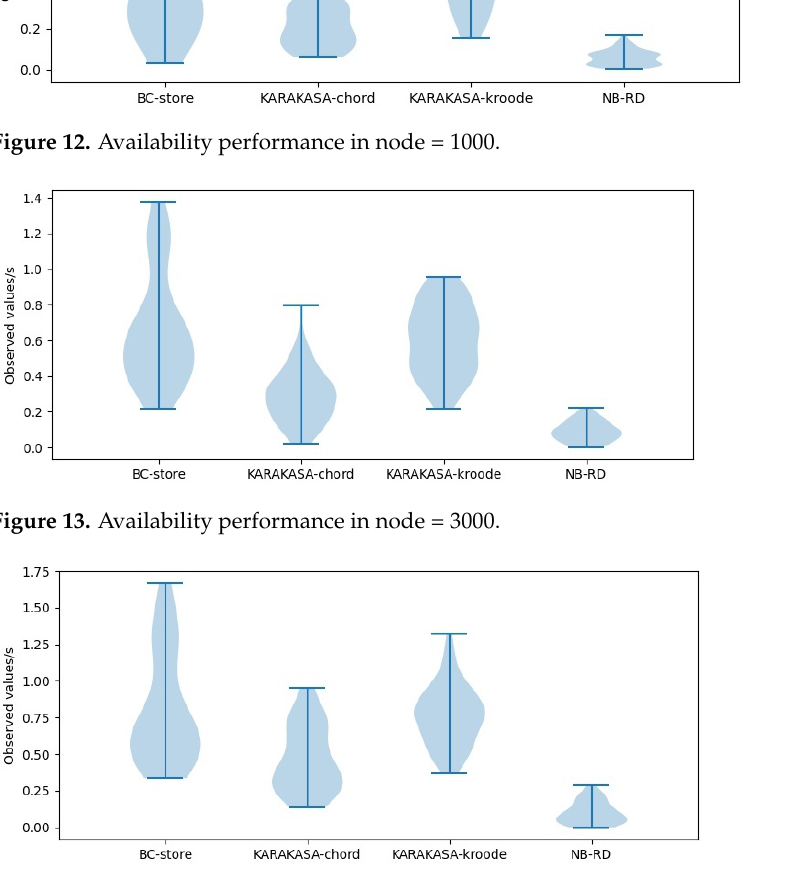
Figure 14. Availability performance in node =